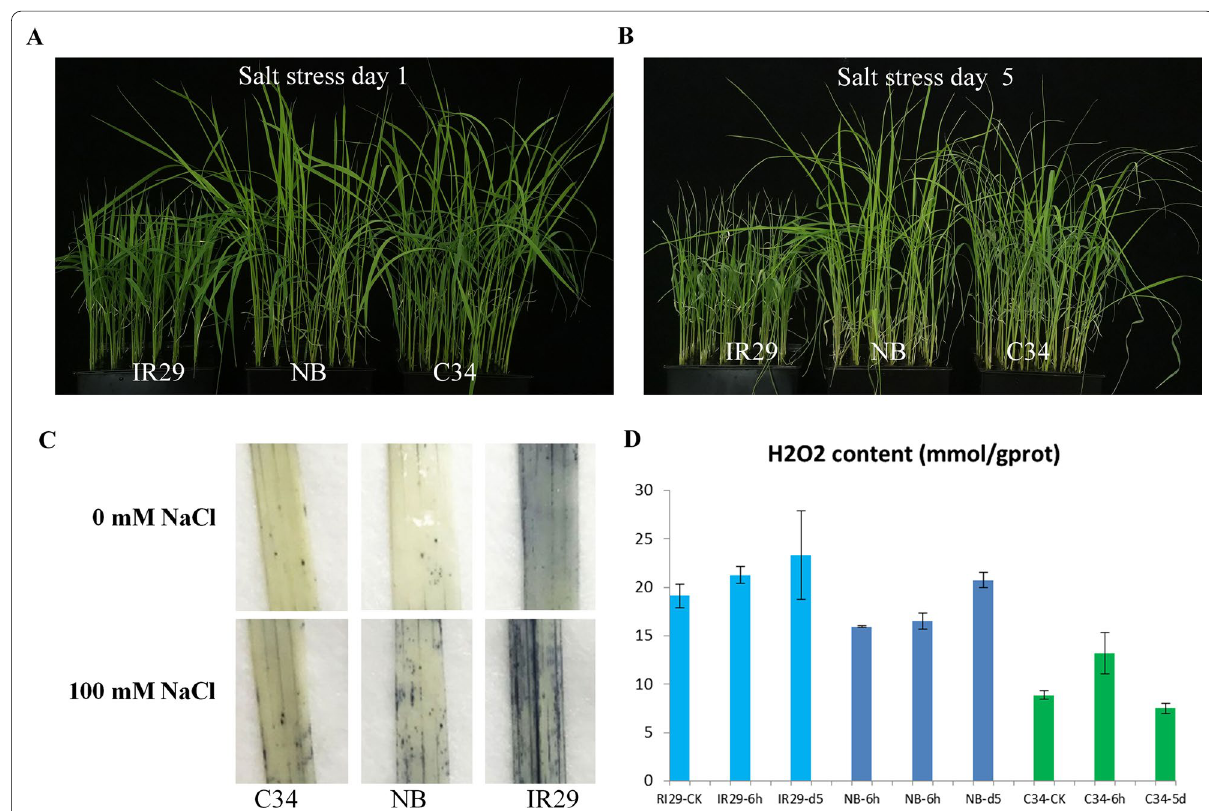
Fig. 1 Phenotype and ROS accumulation of rice leaves after salt stress. A . Phenotype of the three rice varieties after 100 mM NaCl treated for 1 day. B . Phenotype of the three rice varieties after 100 mM NaCl treated for 5 days. C . ROS staining on leaves without NaCl treatment. Lower panels, ROS staining on leaves from seedlings treated with 100 mM NaCl for 5 days. Sample IDs were indicated. D . H 2 O 2 contents in the second leaf of each rice varieties. Salt treatment durations were 0 h, 6 h and 5d,